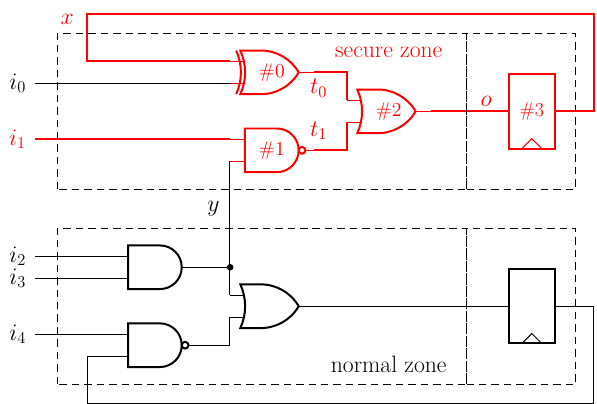
Figure 4: Exemplary circuit after the propagation of secure signals. i 1 is the only primary input marked as secure. The red signals and cells indicate the extracted parts which should be masked. Table 1: Supported masking schemes and processing